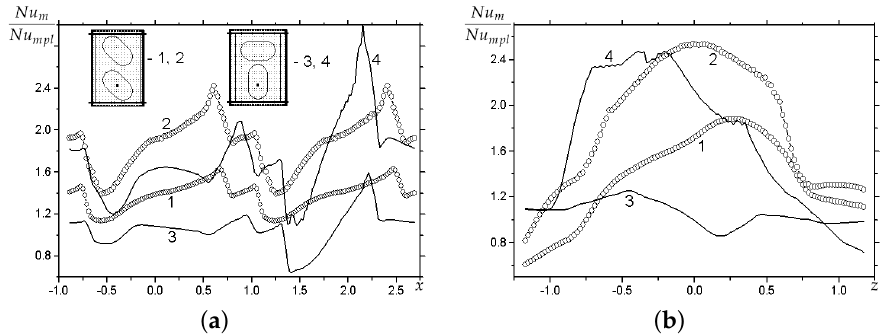
Figure 19. Relative heat transfer averaged over the area strip with dimples in the longitudinal ( a ) and transverse ( b ) directions for ladder arrangement (1, 2) and longitudinal-transverse arrangement (3, 4). ∆ = 0.1 ( 1,3 ) ; 0.2 ( 2,4 )